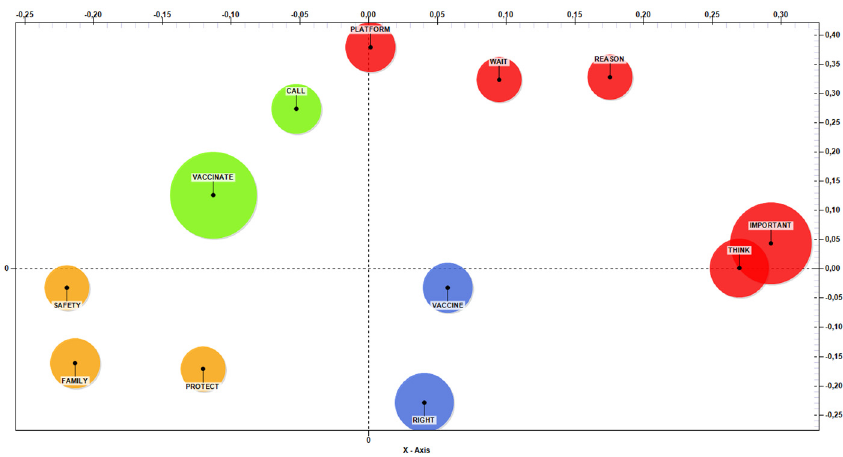
Figure 1. Co-word analysis (MDS = Sammon method; stress = 0.0247).